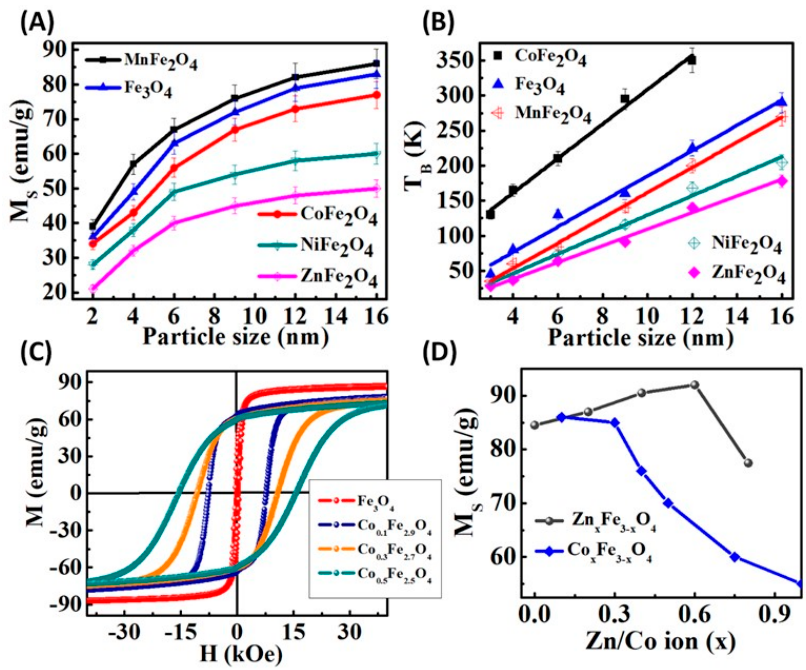
Figure 9. ( A ) Saturation magnetization vs. NPs size plot for MFe 2 O 4 NPs demonstrates the sharp increase of magnetization value with respect to NPs size [92]. ( B ) Blocking temperature vs. NPs size plot indicates a linear relationship between blocking temperature and NPs size [92]. ( C ) Hysteresis curves of Co x Fe 3- x O 4 nanoparticles with x = 0, 0.1, 0.3 and 0.5 at 10 K [100]. ( D ) Dependences of M S on the Zn and Co substitution content ( x ) in Fe 3 O 4 nanoparticles [99,102]. Materials 2017 , 10 , x FOR PEER